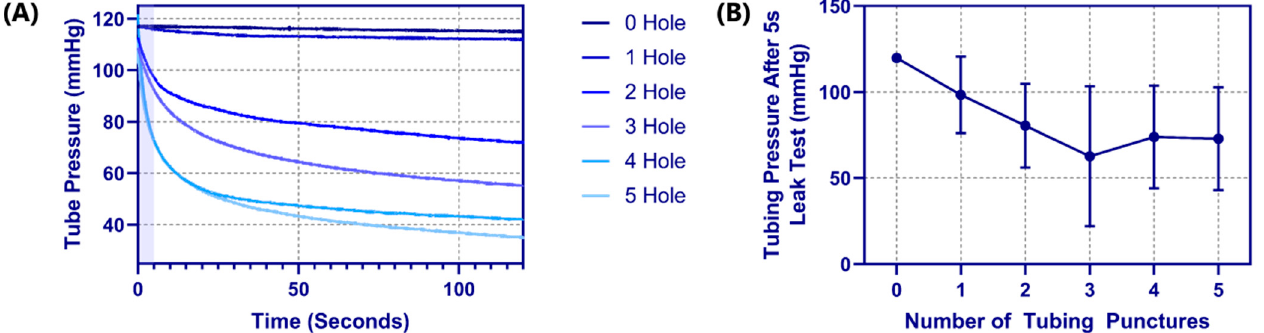
Figure 5. Tubing leak test results for the phantom platform. ( A ) Pressure decay vs. time plots for a single tubing piece with 0 to 5 holes in the tubing, for 120 s. The shaded region indicates the 5 s window that was used for comparing across tubing pieces. ( B ) Results for tubing pressure after 5 s into the leak test are shown for 0 to 5 puncture holes in the tubing pieces. Results are shown as mean ( n = 4 tubing pieces) with error bars denoting standard deviations.